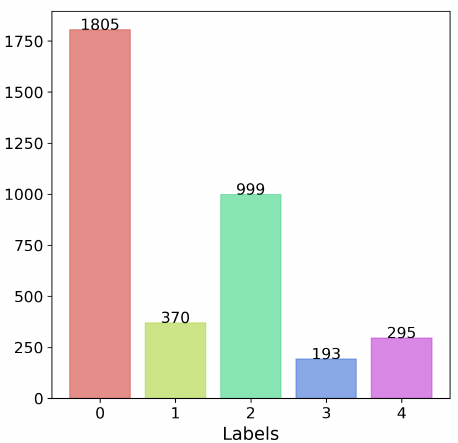
Figure 5. Sample images of APTOS dataset. ( a ) is a picture of Non-diabetic retionpathy which is ordinary case and ( b ) is a picture of diabetic retinopathy which cas cause blindness.